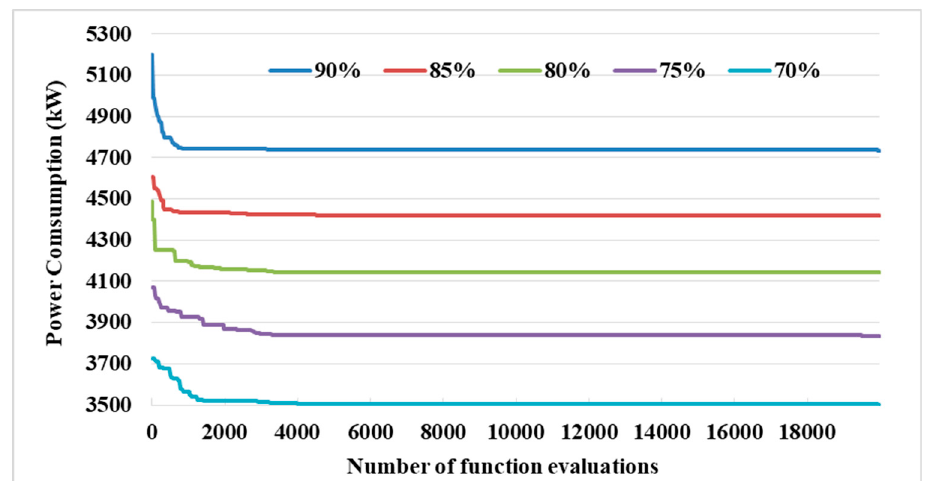
Figure 5. Convergence of two-stage DE for case study 1.